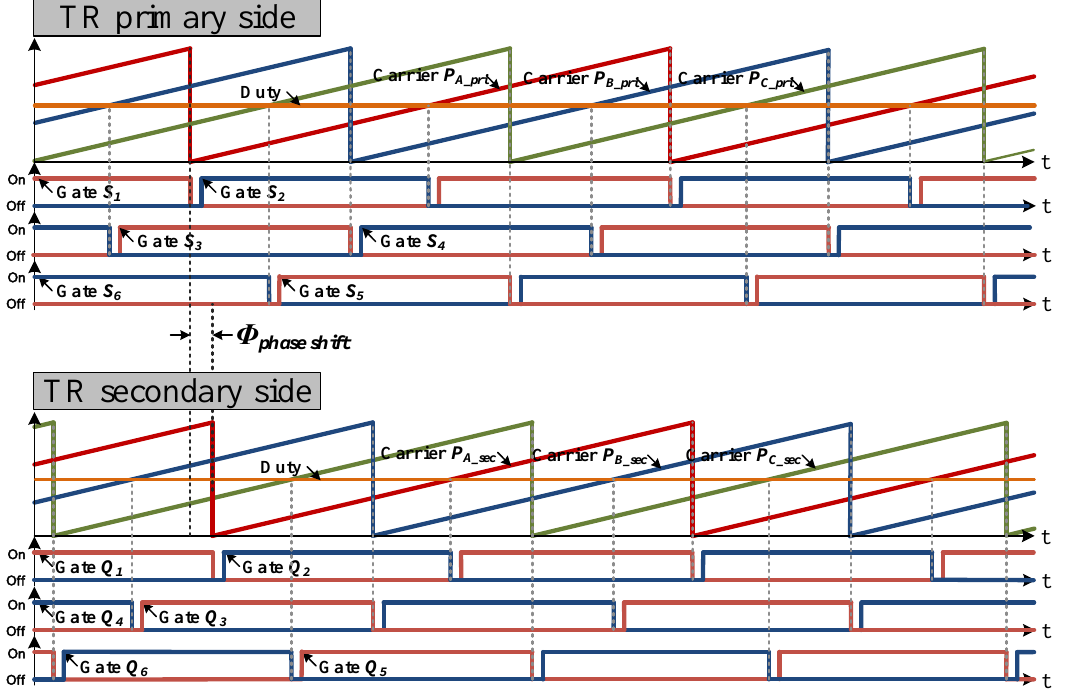
Figure 3. The modulation and switching operation of 3P-CFDAB converter.